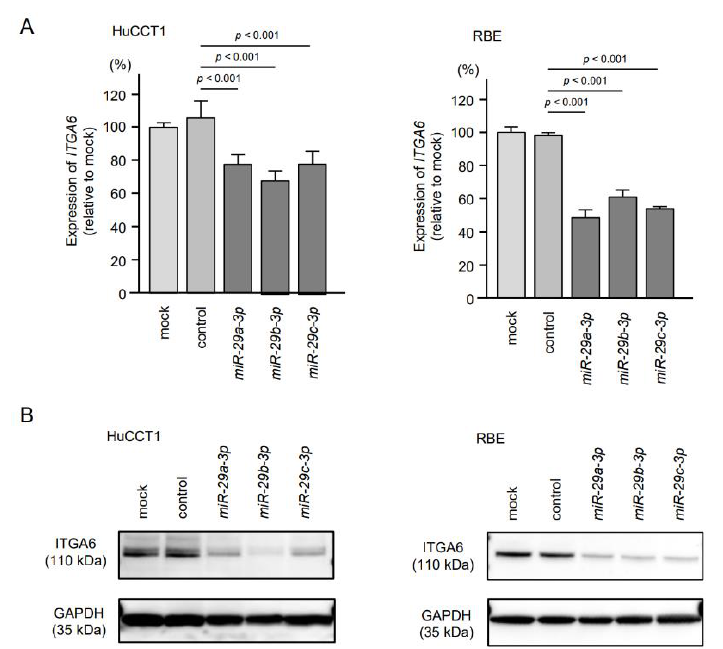
Figure 5. Regulation of ITGA6 /ITGA6 expression by ectopic expression of miR-29a-3p , miR-29b-3p and miR-29c-3p in intrahepatic cholangiocarcinoma (ICC) cells. ( A ) Expression levels of ITGA6 were significantly reduced by miR-29-3p transfection into ICC cells. GUSB was used as an internal control. ( B ) Protein expression levels of ITGA6 were significantly reduced by miR-29- family transfection into ICC cells (72 h after transfection). GAPDH was used as an internal control.